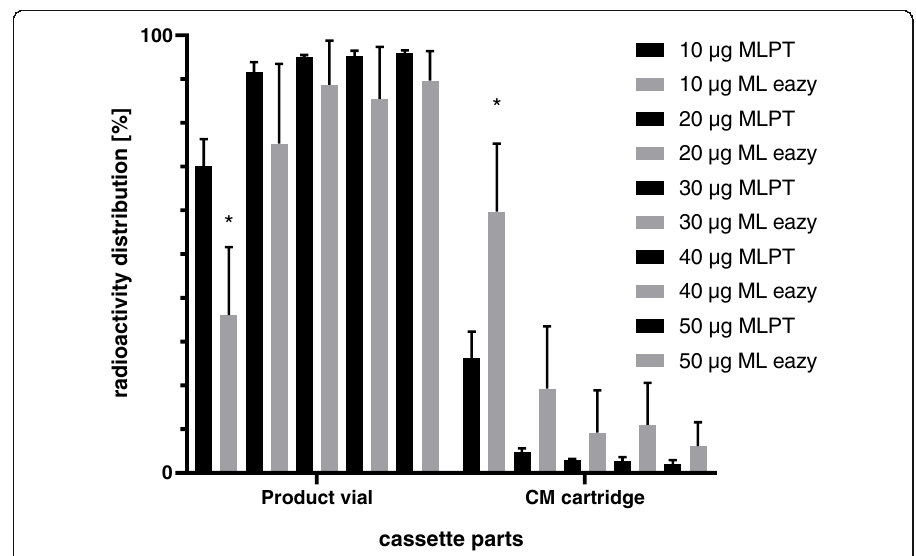
Fig. 2 Radioactivity distribution on cassette parts after synthesis on MLPT (95 °C) and ML eazy (98 °C) (dark: MLPT; light: ML eazy) with increasing peptide load from left to right (10 μ g – 50 μ g); * = p -value < 0.05